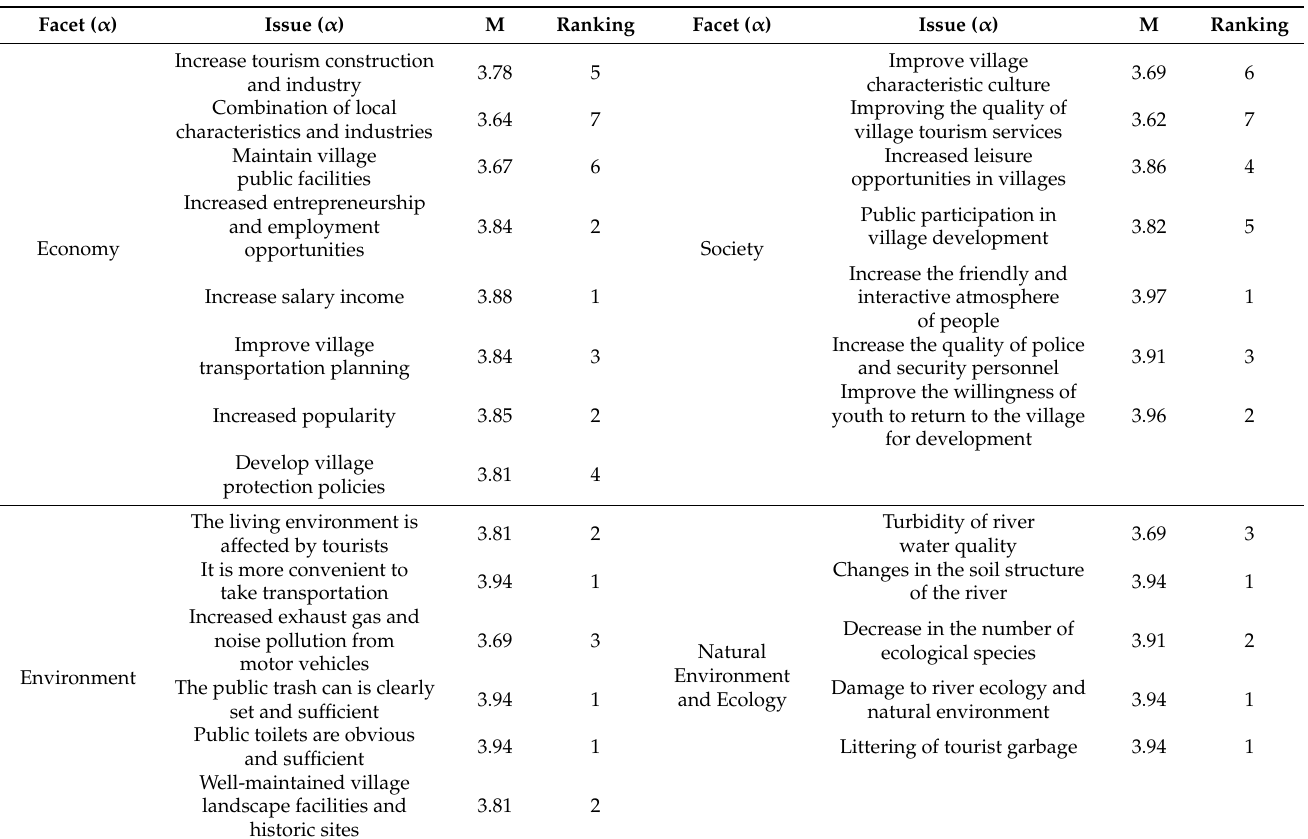
Table 2. Cognitive analysis of the current situation of village economic, social, environmental, and natural ecological